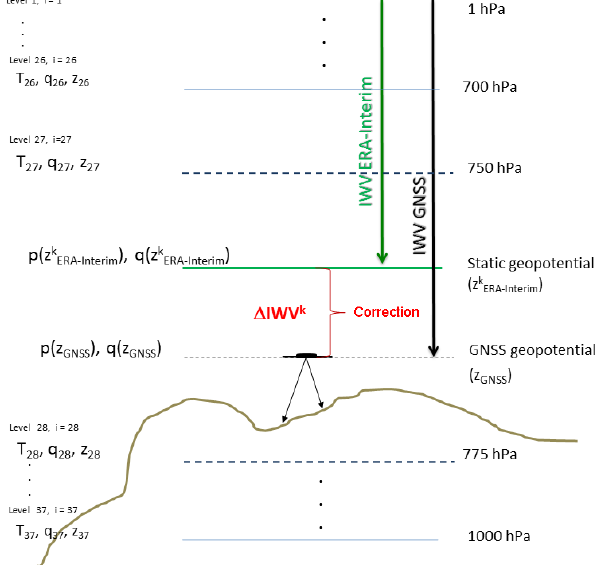
Figure 3. Scheme of the applied correction to the IWV from the ERA-Interim reanalysis for one of the four grid points ( k ) at a given instant. Both unknowns ( z GNSS , dark gray dashed line, and z k , thick green line) are located between the pressure lev- NWM els 27 (750hPa) and 28 (775hPa), indicated using thick dashed lines. Atmospheric pressure ( p i ), temperature ( T i ), specific humid- ity ( q i ) and geopotential ( z i ) are known at the 37 levels from 1 to ) and p(z GNSS ) are calculated 1000hPa. Values of p(z k ERA-Interim ) and q(z GNSS ) from Eq. (5), whereas the values of q(z k ERA-Interim resulted from a linear interpolation. The computation of (cid:49) IWV k must be carried out four times ( k = 1 ,..., 4) prior to the bilinear interpolation that produces (cid:49) IWV ERA-Interim for the given instant.